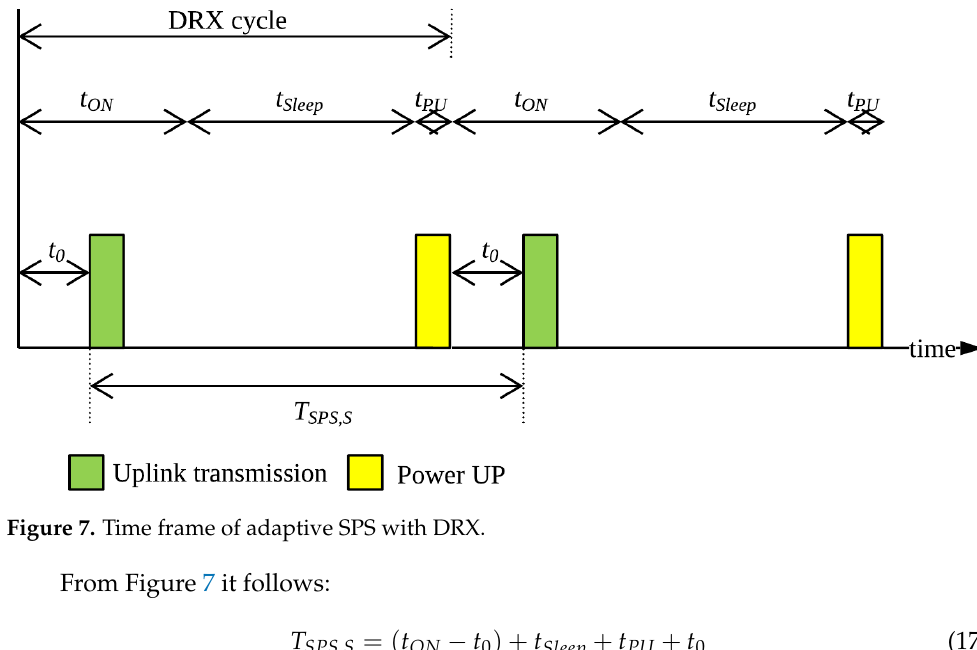
Figure 7. Time frame of adaptive SPS with